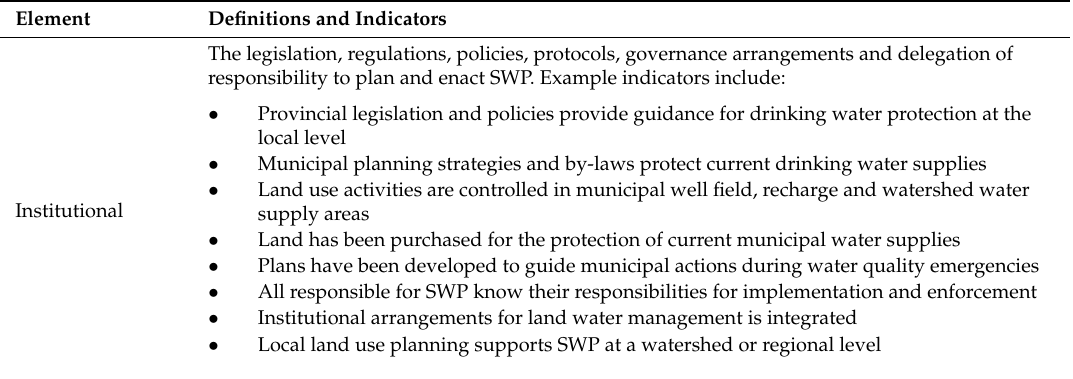
Table A1. Elements of Capacity for Source Water Protection *